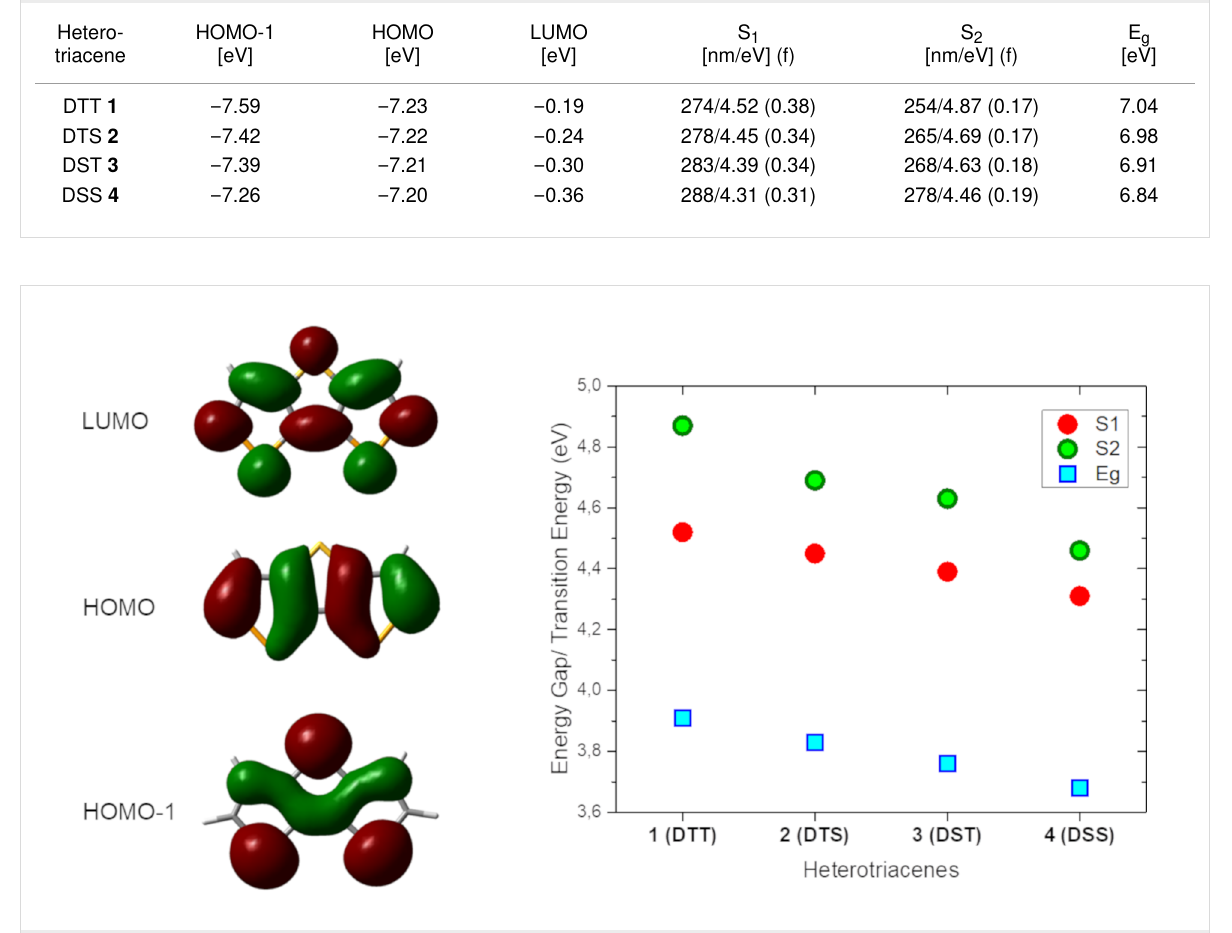
Table 3: DFT and TDDFT quantum chemical calculations on heterotriacenes 1–4 .